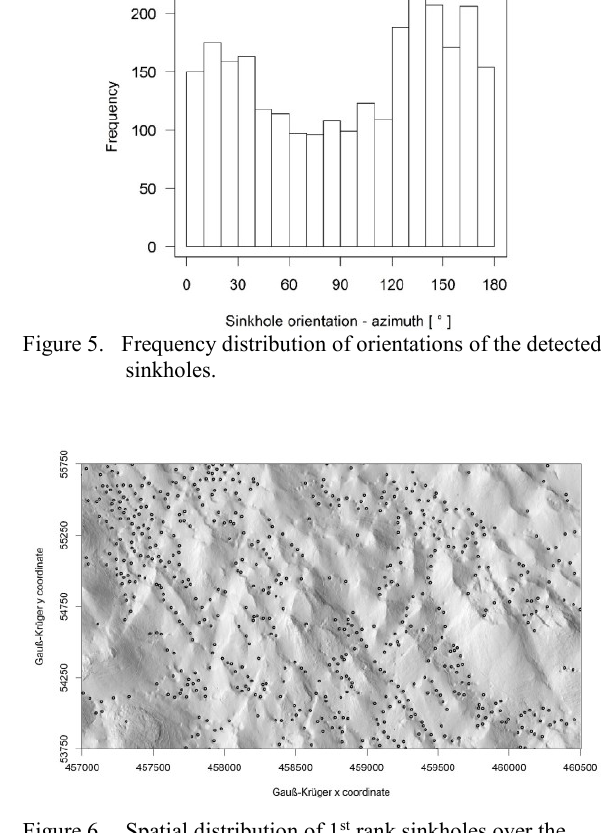
Figure 4. Circularity index boxplots same letter means no difference according to Kruskal-Wallis test